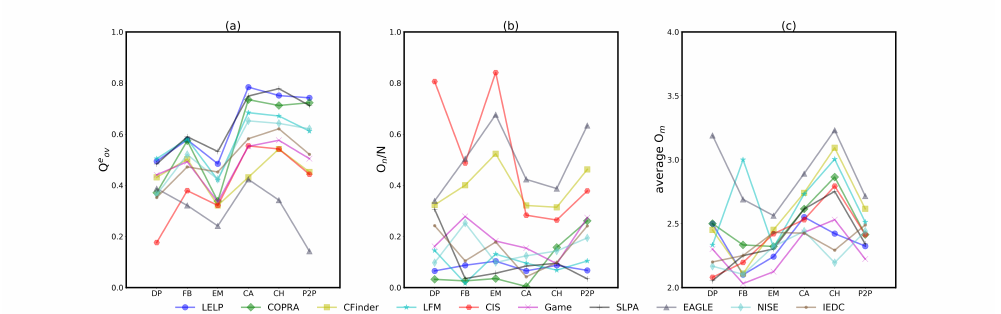
Figure 6. Sub figure ( a – c ) respectively represent overlapping modularity Q e ov , the proportion of overlapping node O n /N and average number of community memberships Q m of different algorithms in 6 real-world